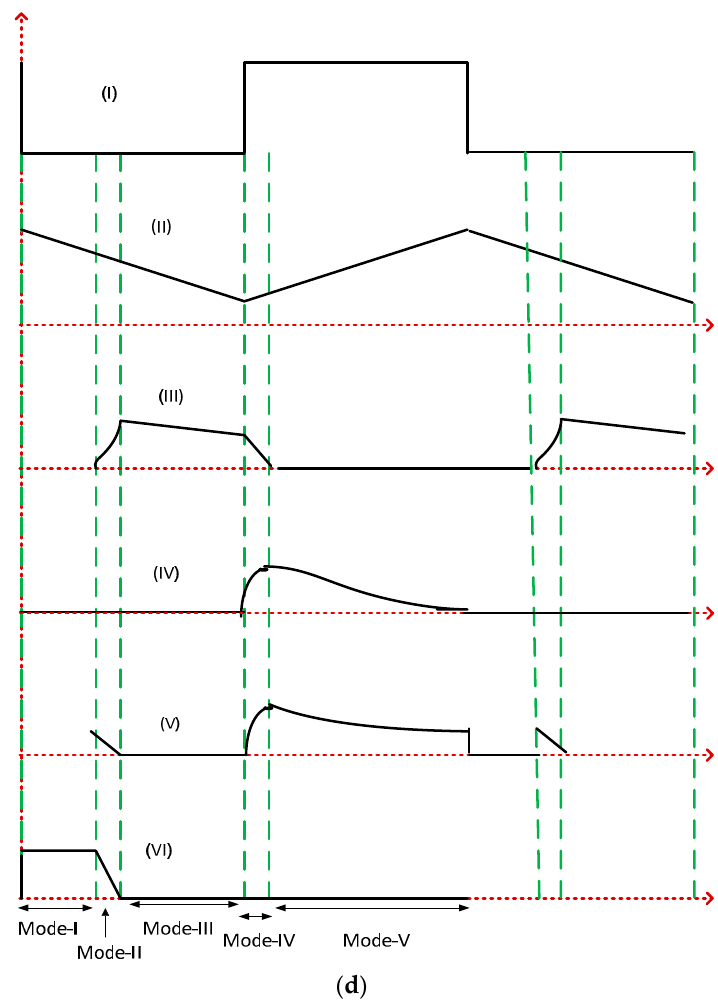
Figure 6. ( a ) Switching signal for a 75% duty cycle. ( b ) Switching signal for a 50% duty cycle. ( c ) Waveforms for the continuous conduction mode (Phase I): (i) Switching signal; (ii) Magnetizing inductance current; (iii) Current through D 3 ; (iv) Current through diode D 2 ; (v) Primary inductor L 1 current; (vi) Current through diode D 1 . ( d ) Waveforms for the continuous conduction mode (Phase II): (i) Switching signal; (ii) Magnetizing inductance current; (iii) Current through 𝐷 (cid:2874) ; (iv) Current